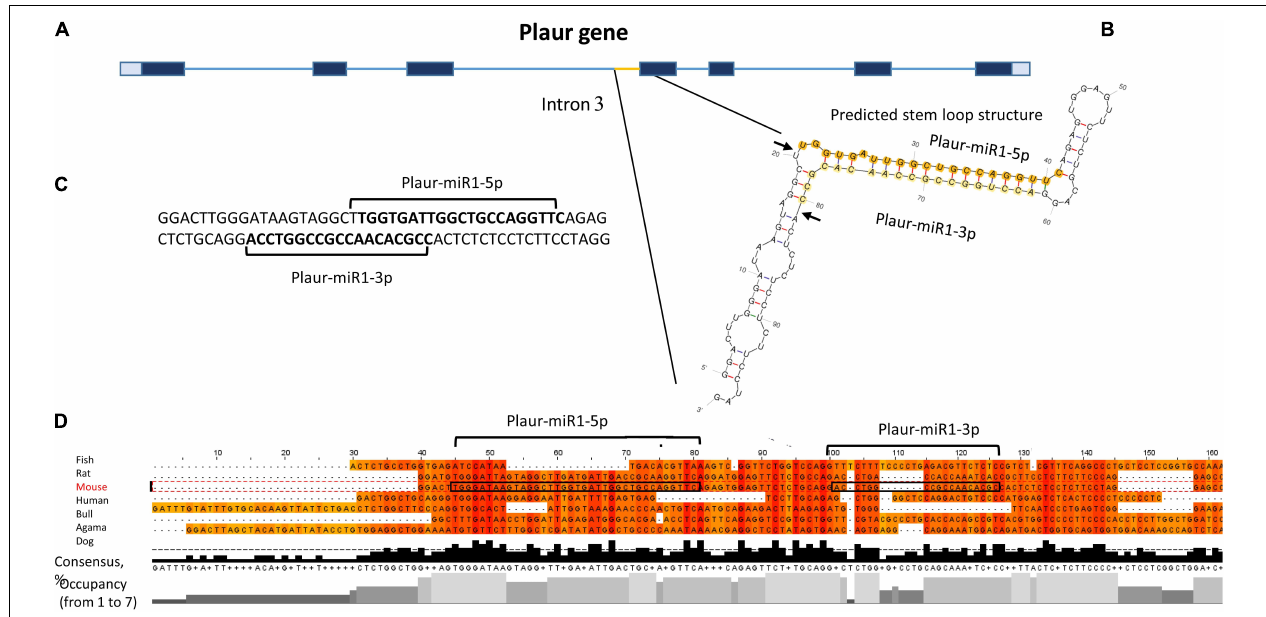
FIGURE 2 | Identification of novel small RNAs Plaur-miR1: Plaur-miR1-3p and Plaur-miR1-5p in the Mus musculus Plaur gene. (A) Schematic overview of mouse Plaur gene, adapted from NCBI Genome browser. Untranslated regions are shown in gray. Exons and introns are indicated as blue rectangles and lines, respectively. (B) The predicted stem-loop structure of Plaur-miR1 from Plaur intron 3. Arrows indicate predicted sites of Drosha cleavage; mature miRNAs from the stem-loop, namely Plaur-miR1-5p and Plaur-miR1-3p, are highlighted in orange and yellow, respectively. (C) The duplex part of the stem-loop is indicated; sequences of mature Plaur-miR1-5p and Plaur-miR1-3p predicted by MatureBayes are shown in bold (predicted Drosha cutting). (D) The intronic region corresponding to the novel miRNA in the Plaur gene is highly conserved among vertebrates. Multiple sequence alignment with Clustal Omega (visualization Jalview 2.11.0) revealed consensus regions matched to mature Plaur-miR1-5p. Areas corresponding to the sequences of mature miRNAs are circled in frames; vertebrate species are indicated on the right. The consensus diagram shows the occurrence of one nucleotide in a given position; the occupancy diagram shows the number of nucleotides in a given